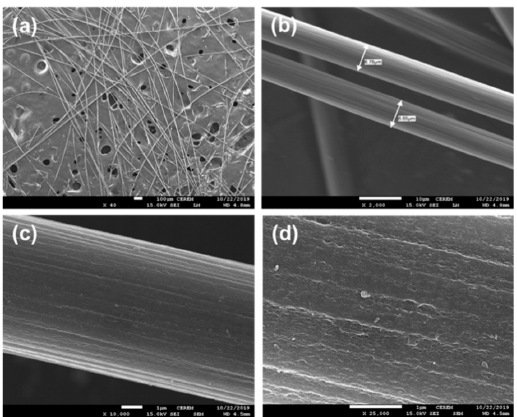
Figure 4. SEM images with di ff erent magnifications of the as-received carbon fibers. ( a – d ) Low to high